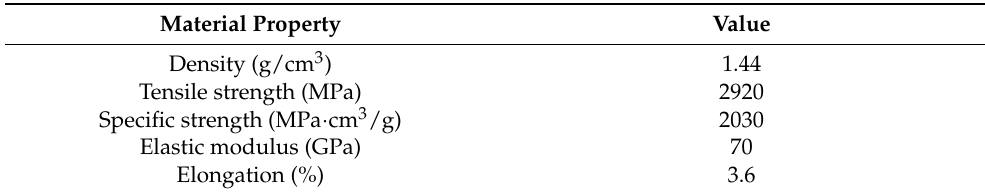
Table 2. Material properties of Kevlar ® 29 fiber.